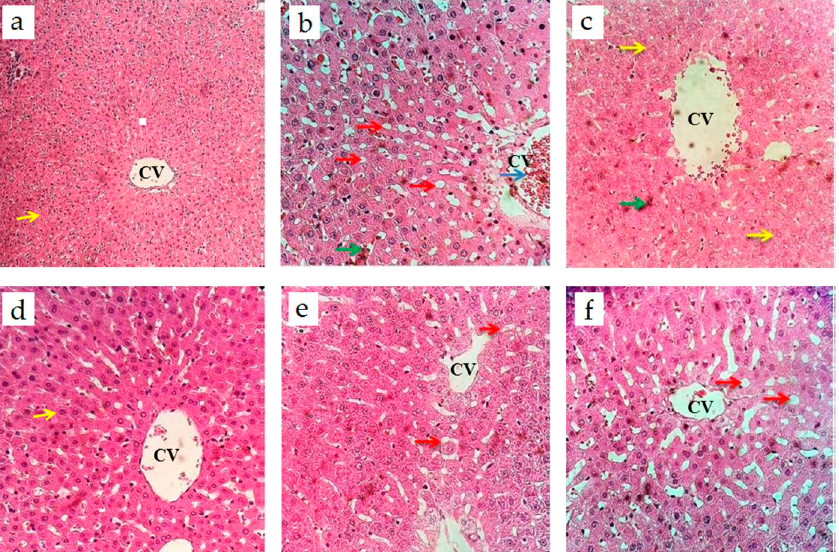
Figure 3. Histology of the livers of experimental rats after 12 days of twice-daily oral treatment with AE: ( a ) NC—the hepatic lobular cells and architecture seemed to be normal; ( b ) DC—Clear red blood cell congestion in the portal vein system (blue arrow) and sinusoids (green arrow), with the accumulation of micro droplets of fat in the centrilobular portion (red arrows); ( c ) Metformin (500 mg/kg b.w.)—Hepatocyte swelling (yellow arrow) and sinusoidal congestion (green arrow) with a decreased number of micro droplets of fat deposit; ( d ) AE (1000 mg/kg b.w.)—normal liver morphology with normal hepatocytes and a central vein; ( e ) AE (500 mg/kg b.w.)—decreased microvesicular fatty change (red arrow); ( f ) AE (250 mg/kg b.w.)—decreased fat micro droplets (red arrow). CV, central vein.